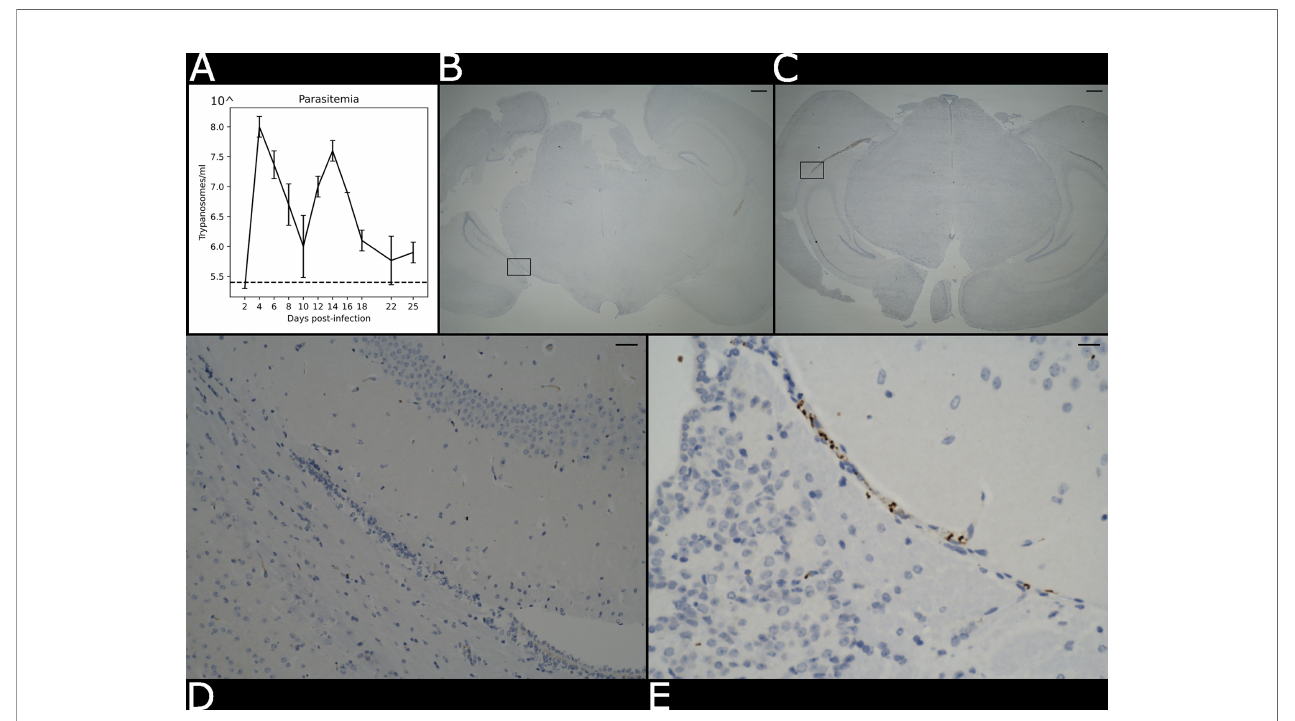
FIGURE 2 | Presence of parasite in the brain parenchyma. (A) Level of parasitaemia in the infected mouse averaged over three biological replicates in a time course of 25 days. The dotted line represents the detection limit of the instrument (10 5.4 trypanosomes/ml). (B) Histological bright fi eld images highlight the presence of parasites in the brain parenchyma in the naïve and (C) infected specimens. Scale bar = 100 µm The boxed region in (B, C) are magni fi ed in (D) e (E) . Scale bar = 25